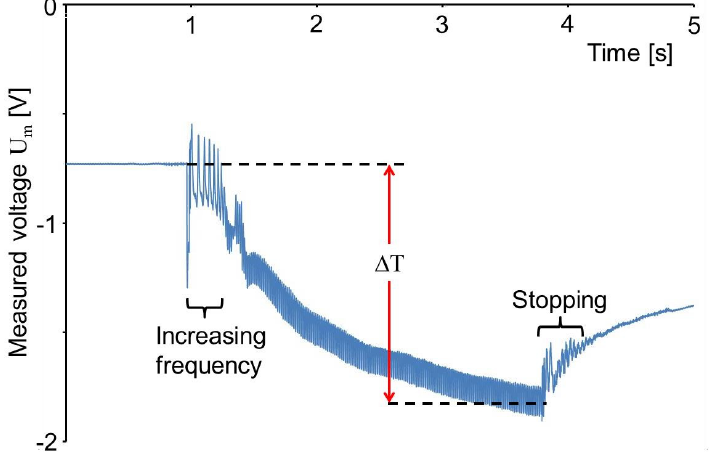
Figure 18. Voltage measured as a function of time by a PVDF sensor foil in a circular friction welding